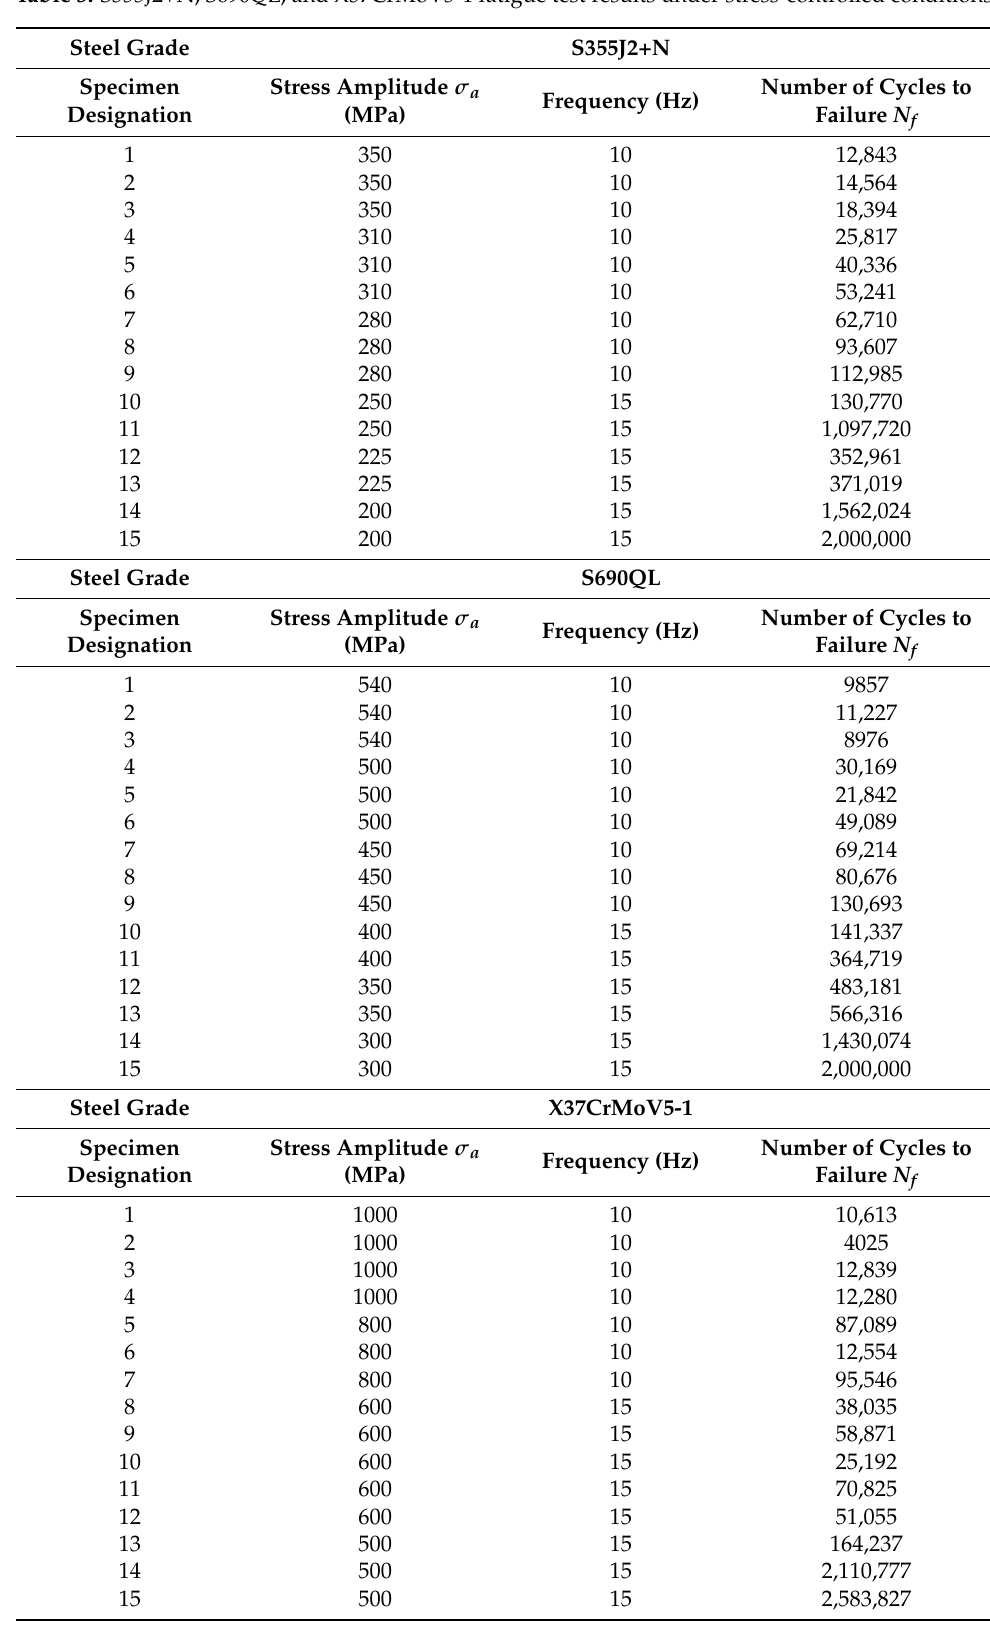
Table 3. S355J2+N, S690QL, and X37CrMoV5-1 fatigue test results under stress-controlled